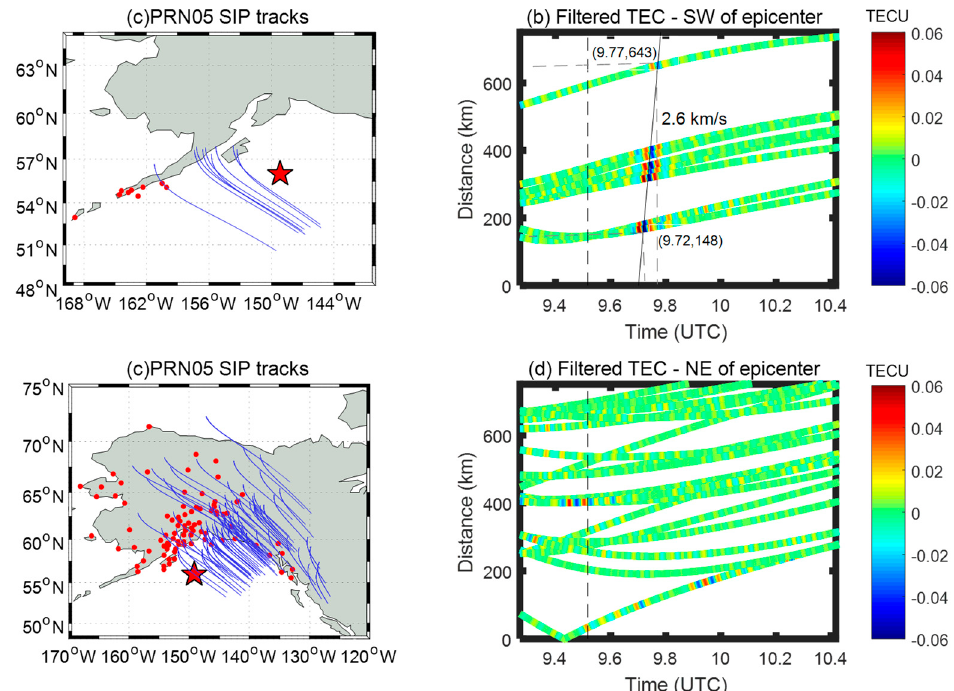
Figure 5. The ionospheric responses to the Alaska earthquake. The left is the SIP tracks between the PRN05 and the stations, and the right is the travel time diagram of filtered TEC series. The dashed line indicates the time of the earthquake eruption, and the diagonal line is used to fit the speed of the TEC disturbances. Different colors show the magnitude of TEC interference.